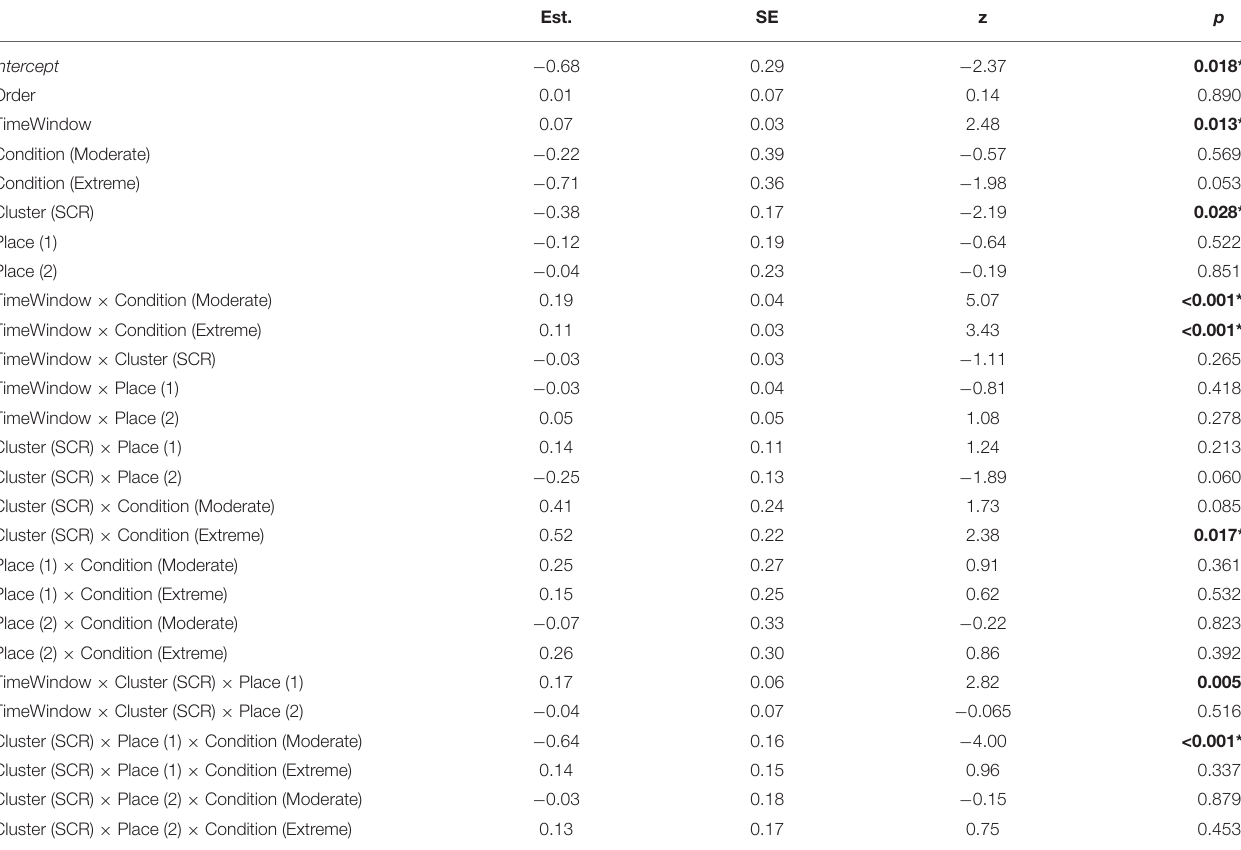
TABLE 4 | Model predictions for all main effects and interactions in fixation accuracy for /sCr/ vs. /sC/ onsets, N = 27,067. Est.